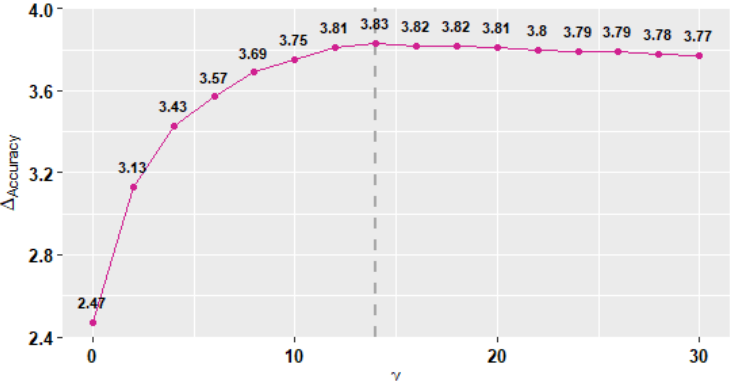
Figure 7. The average changes in both models’ accuracy as the value of γ